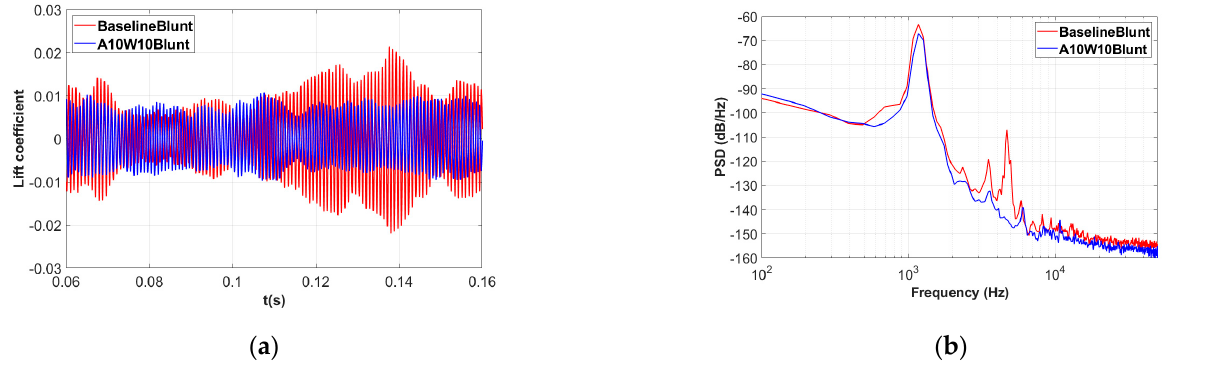
Figure 10. Comparison of the lift coefficient between the baseline airfoil and A10W10 airfoil: ( a ) time domain; ( b ) frequency domain.